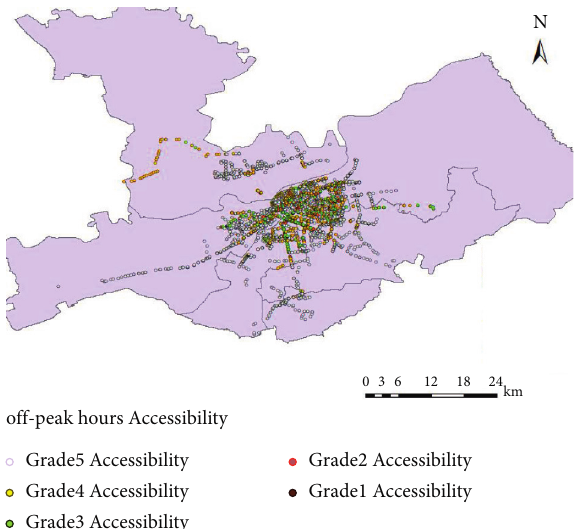
Figure 4: Spatial distribution of accessibility during off-peak hours.